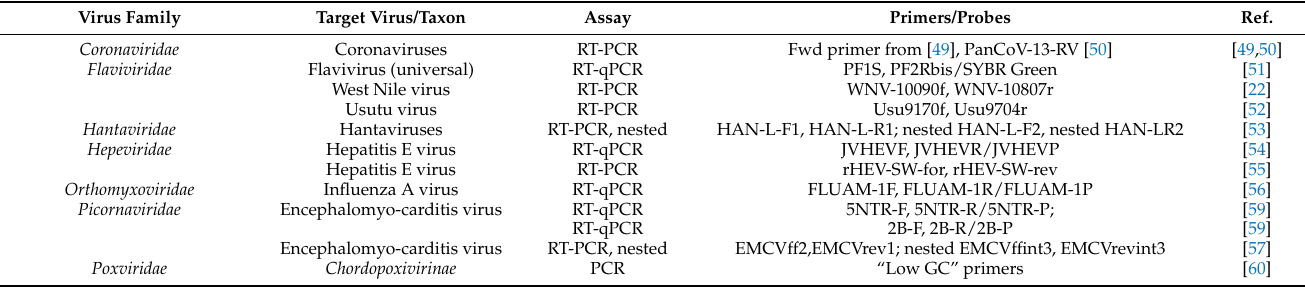
Table 1. PCR-based methods to detect various zoonotic viruses in captured